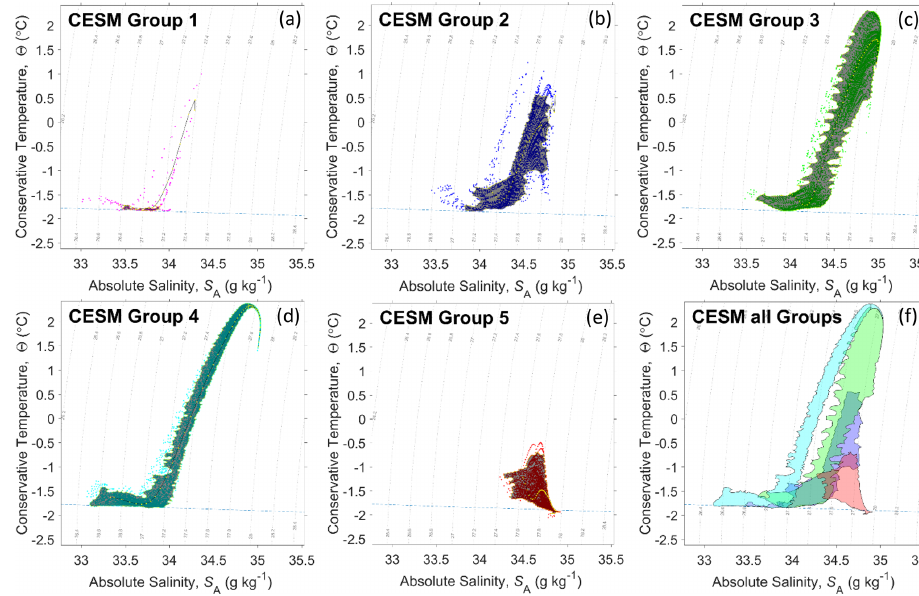
Figure 7. As in Fig. 6 but for the five groups identified in CESM2 (from a to e ) shown in Fig. 3f.